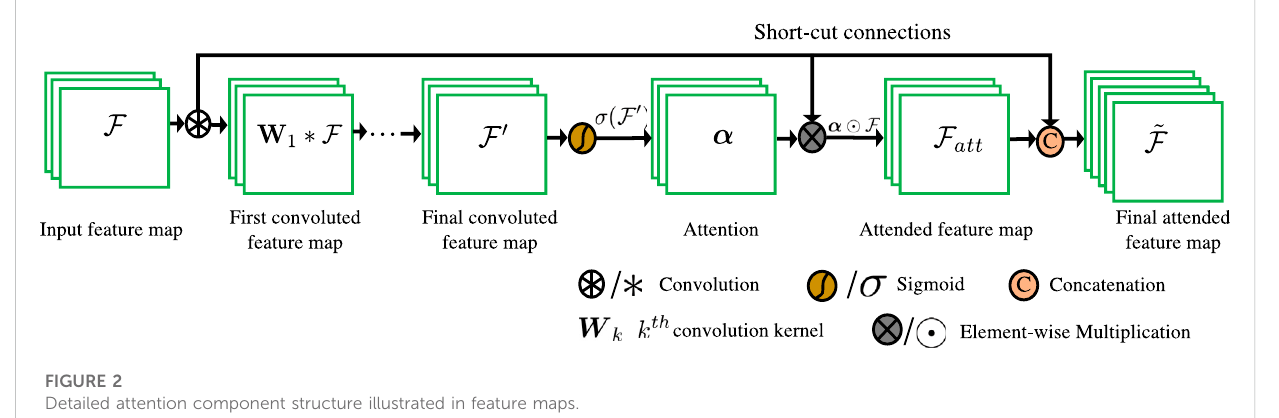
FIGURE 2 Detailed attention component structure illustrated in feature